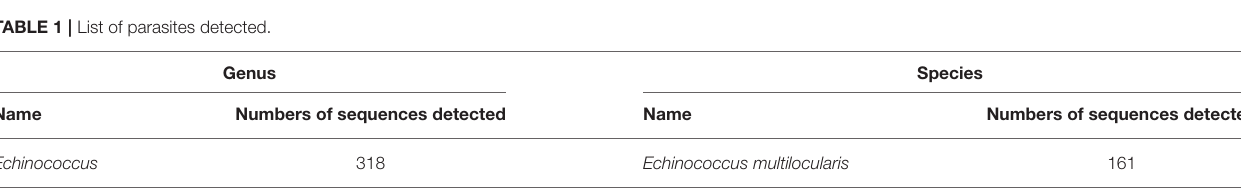
TABLE 1 | List of parasites